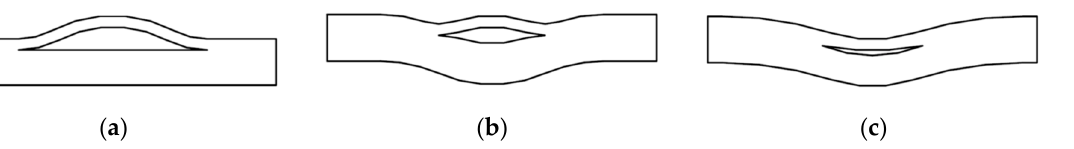
Figure 5. Schematic view of delaminated plates (Arman et al. [56]) and of axisymmetric spherical shells (Muc [17]). ( a ) Local mode, ( b ) mixed mode, ( c ) global mode.